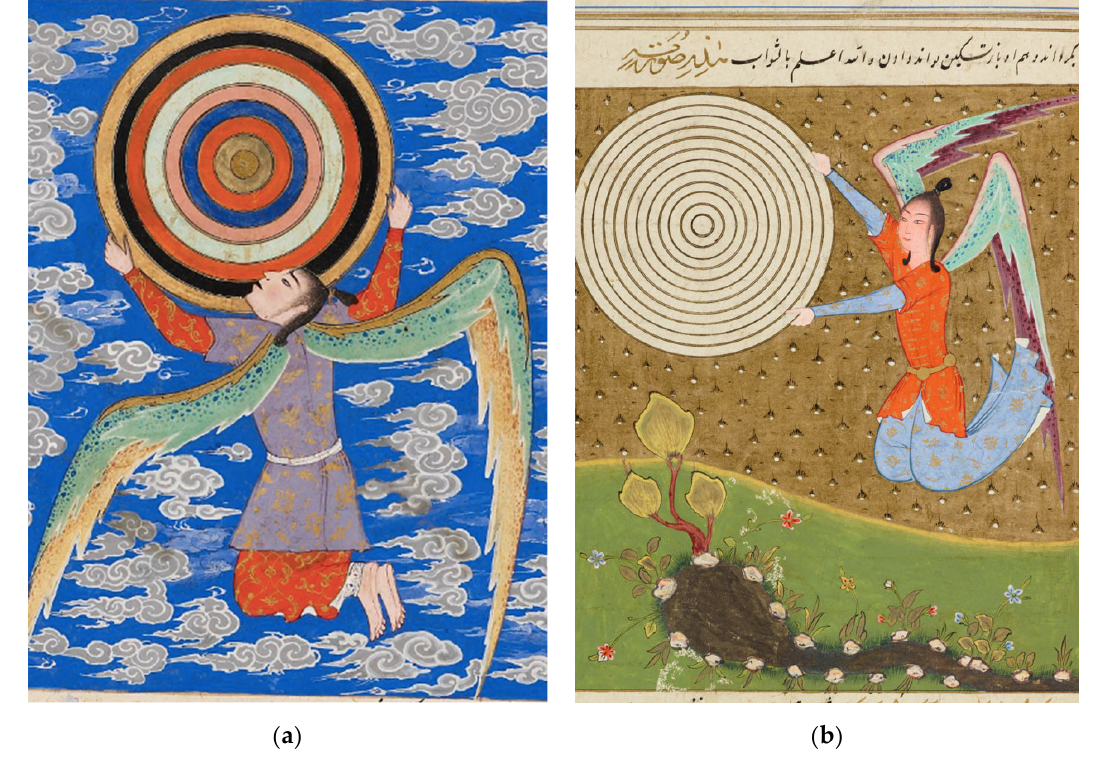
Figure 5. The angel Rukh holding the celestial spheres, The Wonders of Creation and Strange Crea- tures; ( a ) Bodleian Library, University of Oxford, EA1978.2573. © Ashmolean Museum, University of Oxford. 2022 ( b ) “ Aj¯a “ ib al-makhl¯uq¯at , 1566, Cambridge University Library, MS Nn.3.74, 33r. © Cambridge University Library.